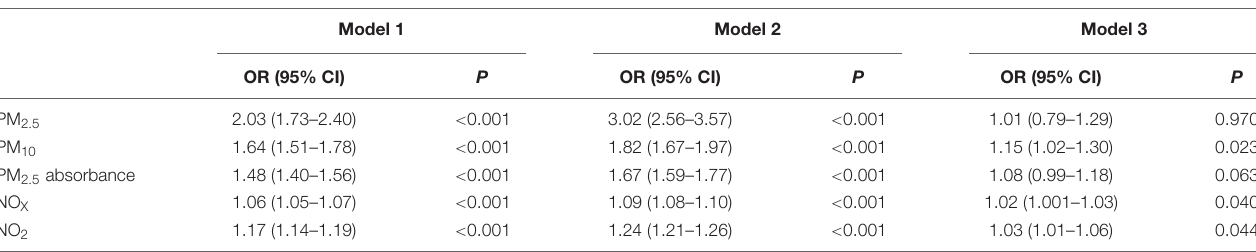
TABLE 2 | Association of air pollution and hearing